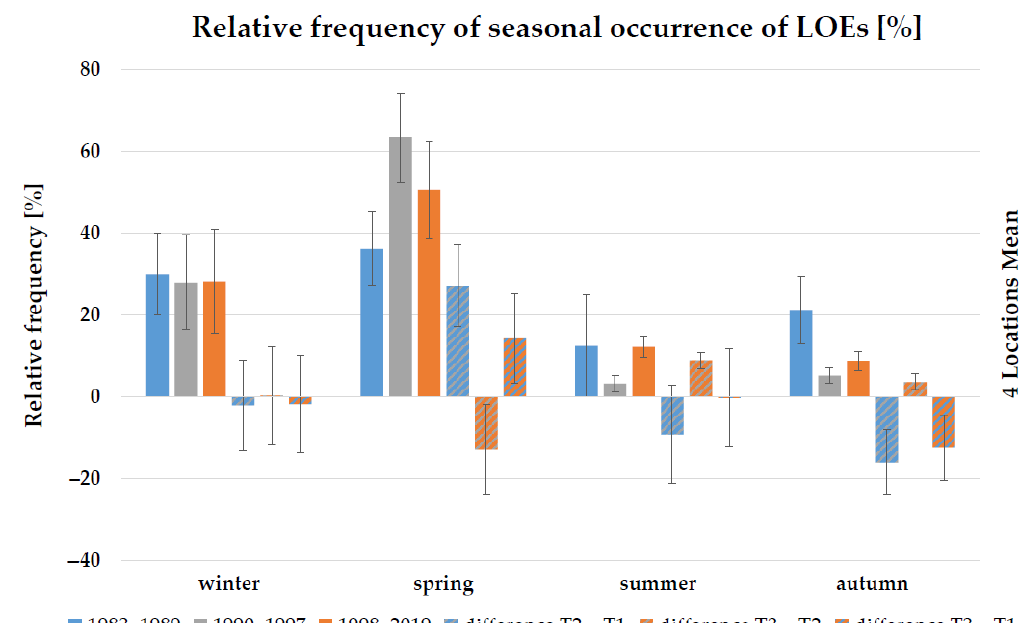
Figure 6. Mean relative frequency of seasonal occurrence of LOEs during the subperiods T1 (1983– 1989), T2 (1990–1997), T3 (1998–2019) and changes between subperiods (4-location means and stand- ard deviations). and standard